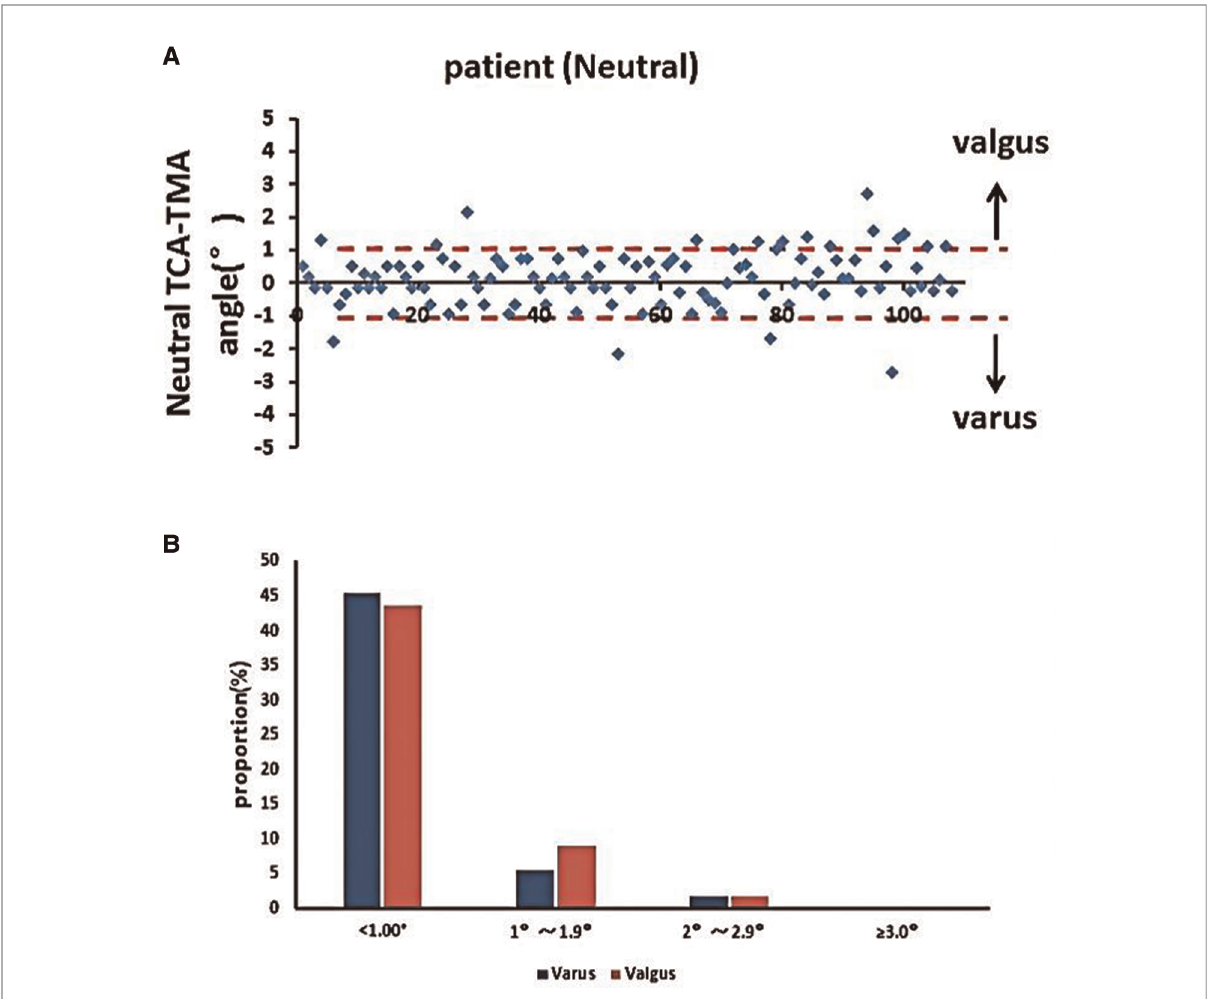
FIGURE 6 Accuracy of TMA mapping on the tibial skin for TPO. ( A ) Distribution of TMA – TCA angles in the neutral position. ( B ) Proportions of TMA – TCA angles after TKA (* p